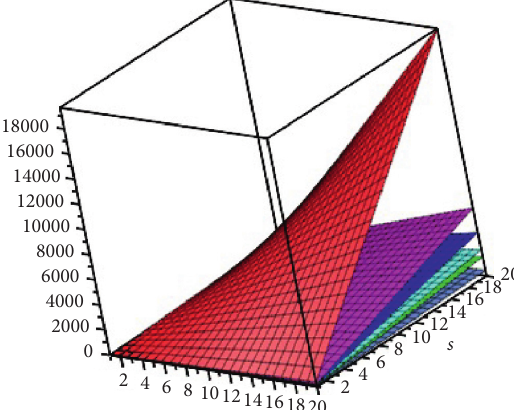
Figure 8: Comparison of first Zagreb coindex index M second Zagreb coindex M of M [ r,s, t ] . Purple and blue represents . 2 5 M and M , respectively. 1 2